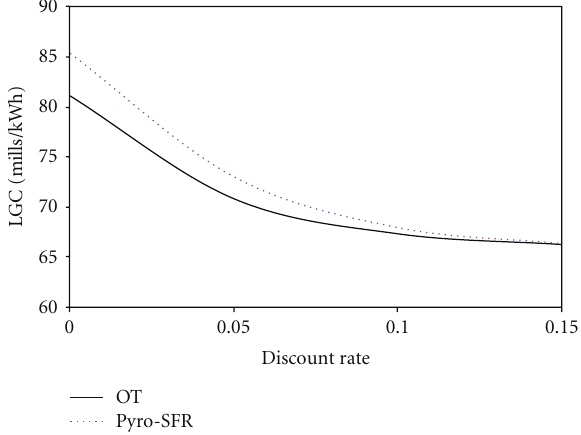
Figure 15: LGC dependent on discount